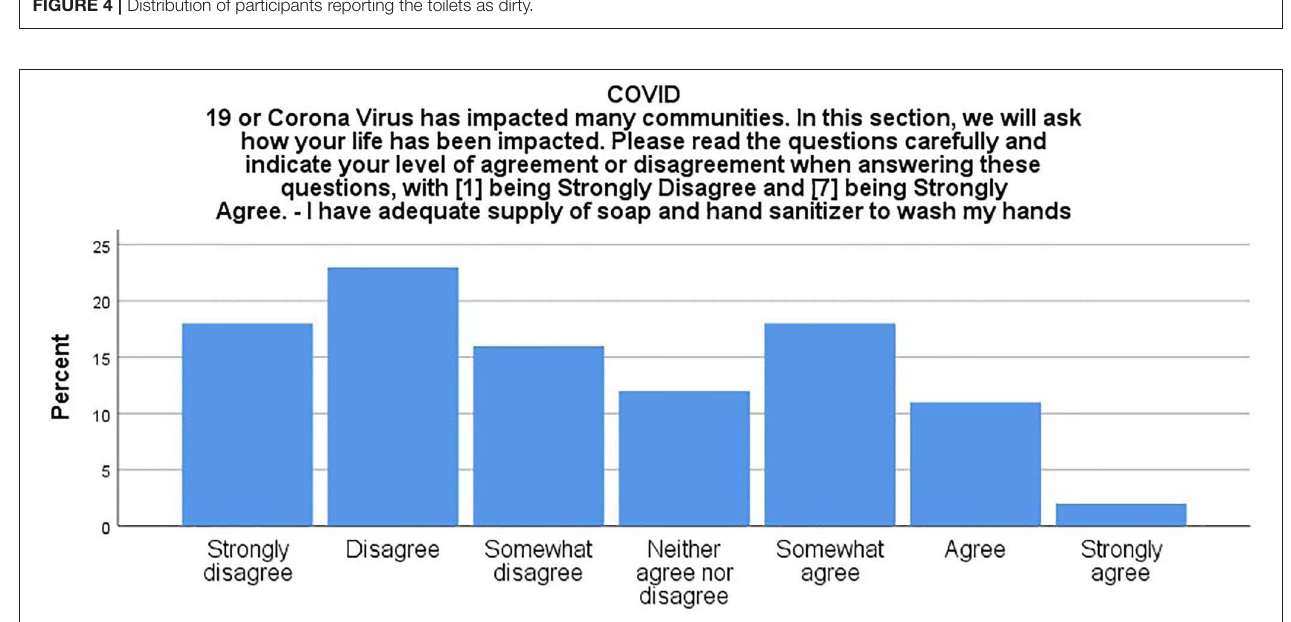
FIGURE 5 | Distribution of participants reporting adequate supply of soap and hand